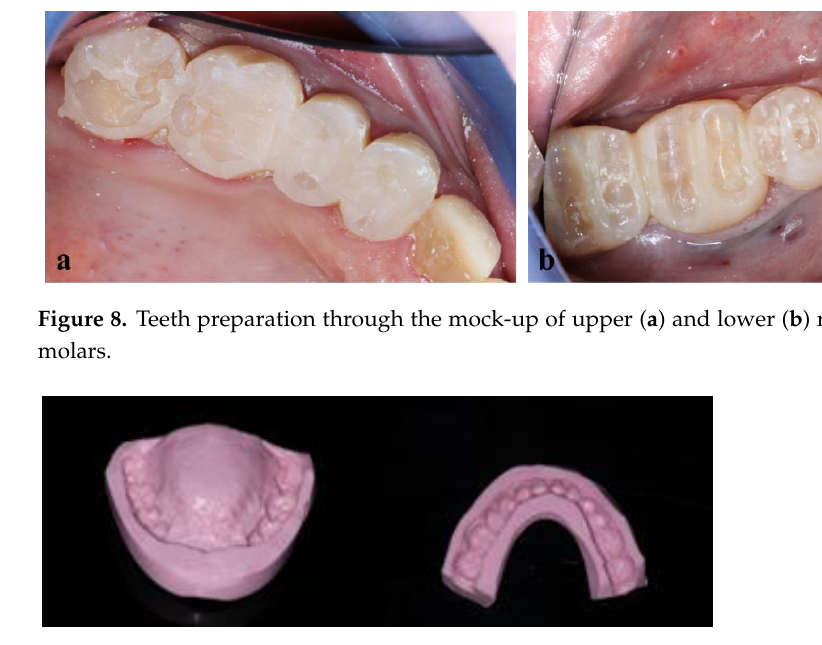
Figure 9. Silicone keys made for repositioning temporary resin after teeth preparations.